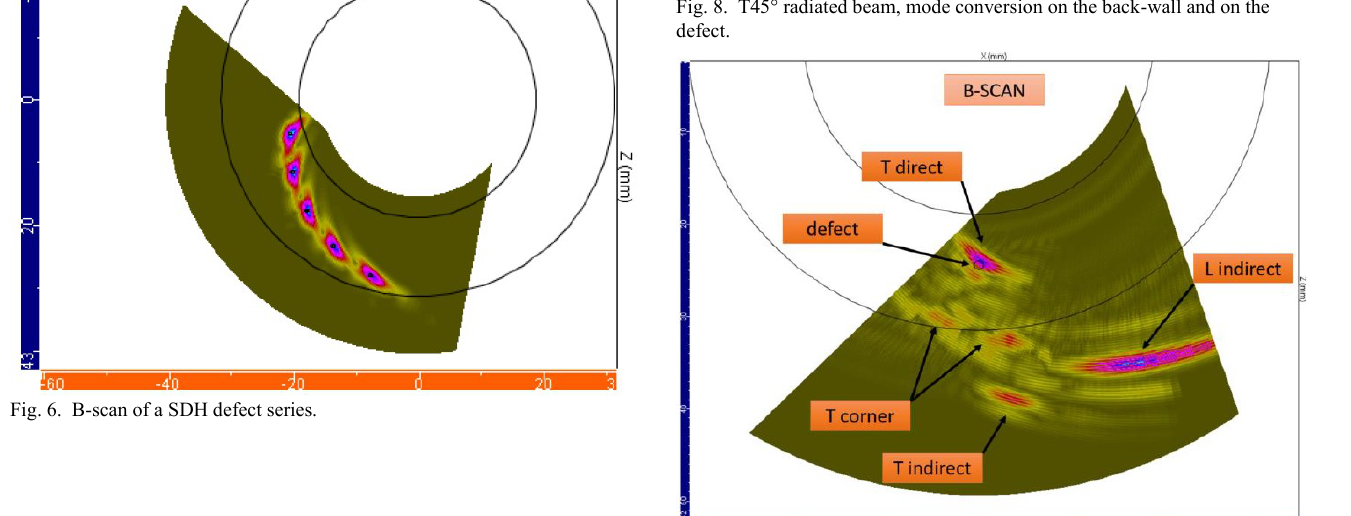
Fig. 9. Identified echoes: 1 mm SDH at 5 mm